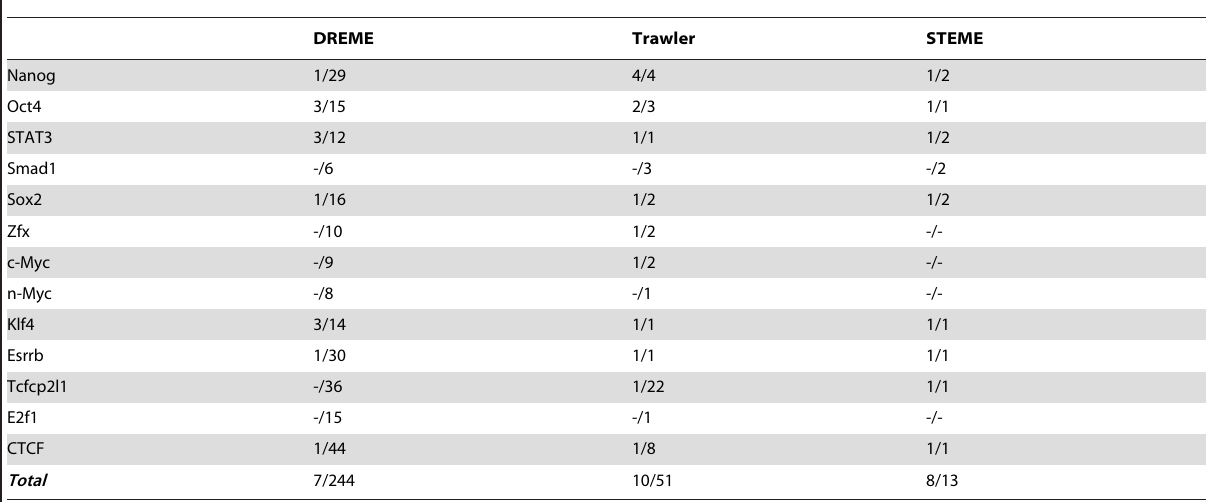
Table 2. Results using the promoter control